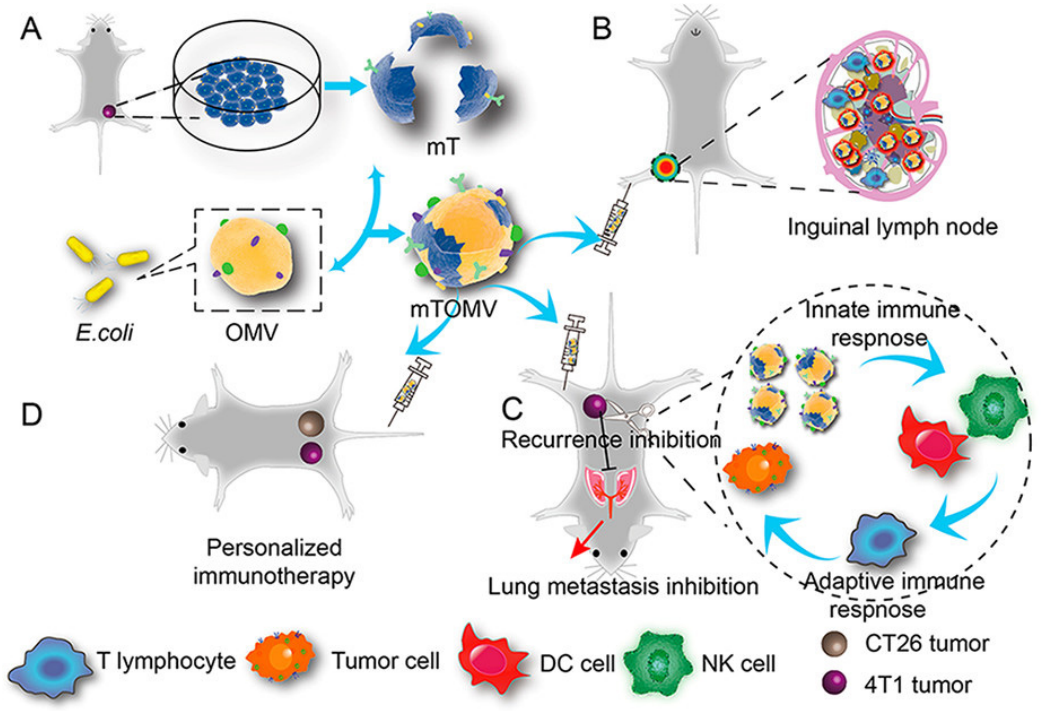
Figure 3. Schematic illustration of fusion vesicles of bacterial outer membrane and TCMVs for personalized immunotherapy. ( A ) The fabrication of fusion vesicles. ( B ) Accumulation and retention behavior of inguinal lymph nodes following right posterior intraplantar injection. ( C ) Fusion vesicles inhibit tumor lung metastasis. ( D ) Bilateral tumor model to validate the effect of fusion vesicle personalized immunotherapy. Reproduced with permission [191]. Copyright 2021, American Chemical Society.